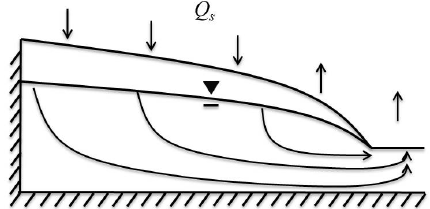
Figure 7. Schematic of a simple profile with a no-flow boundary condition on the left and right (based on symmetry) and transient, spatially varying sources/sinks Q s (x,t) resulting in a recharge and discharge area. In the theory, the vertical and horizontal extent of the cross section is assumed to be